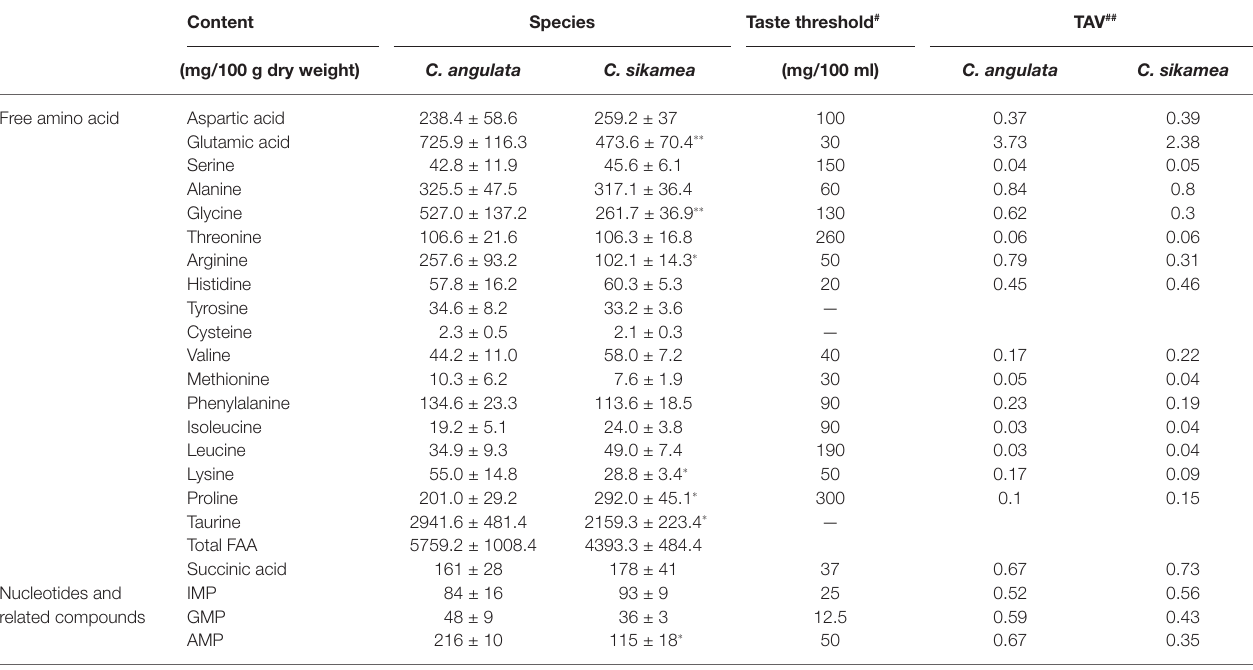
TABLE 2 | Free amino acids, succinic acid (SA), nucleotides and their related compounds content of C. sikamea and C. angulata in Xiangshan bay.